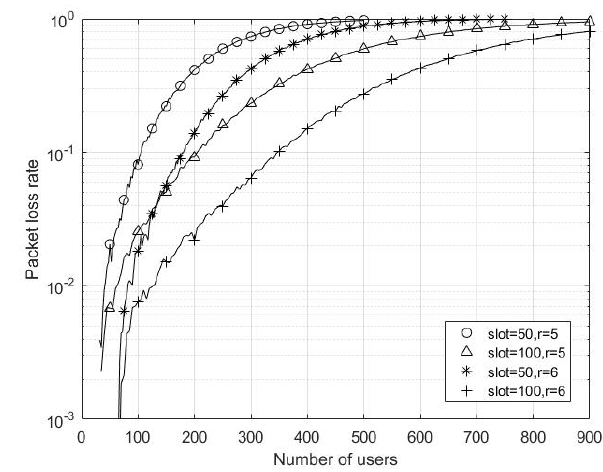
Figure 12. PLR performance curve of Walsh code timeslot random access protocol with different parameters.